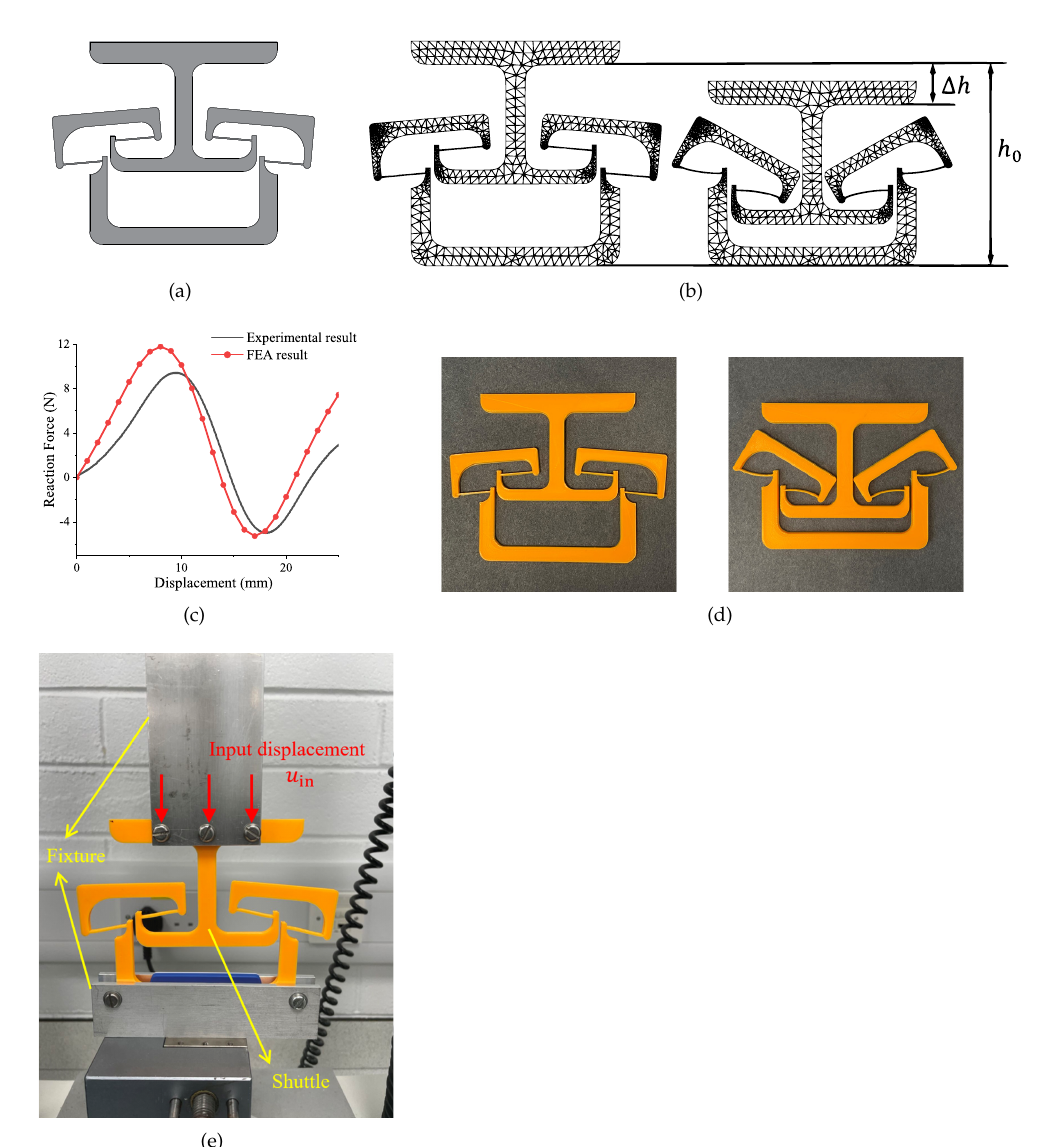
Figure 6. The planar compliant bistable mechanism: ( a ) the design of planar bistable mechanism; ( b ) the deformation result of FEA simulation; ( c ) the comparison between FEA simulation and experiment; ( d ) the 3D-printed prototype using PLA as material; ( e ) the experimental